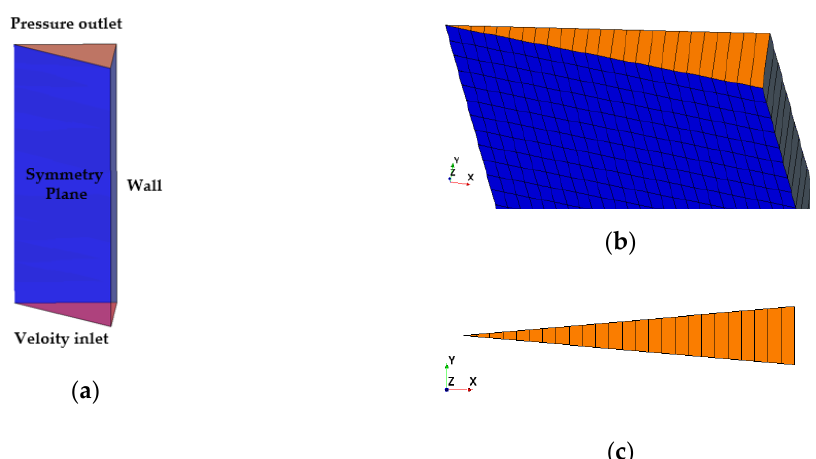
Figure 3. ( a ) Flow domain with boundary conditions, ( b ) grid near the outlet, and ( c ) cross-section of the grid.